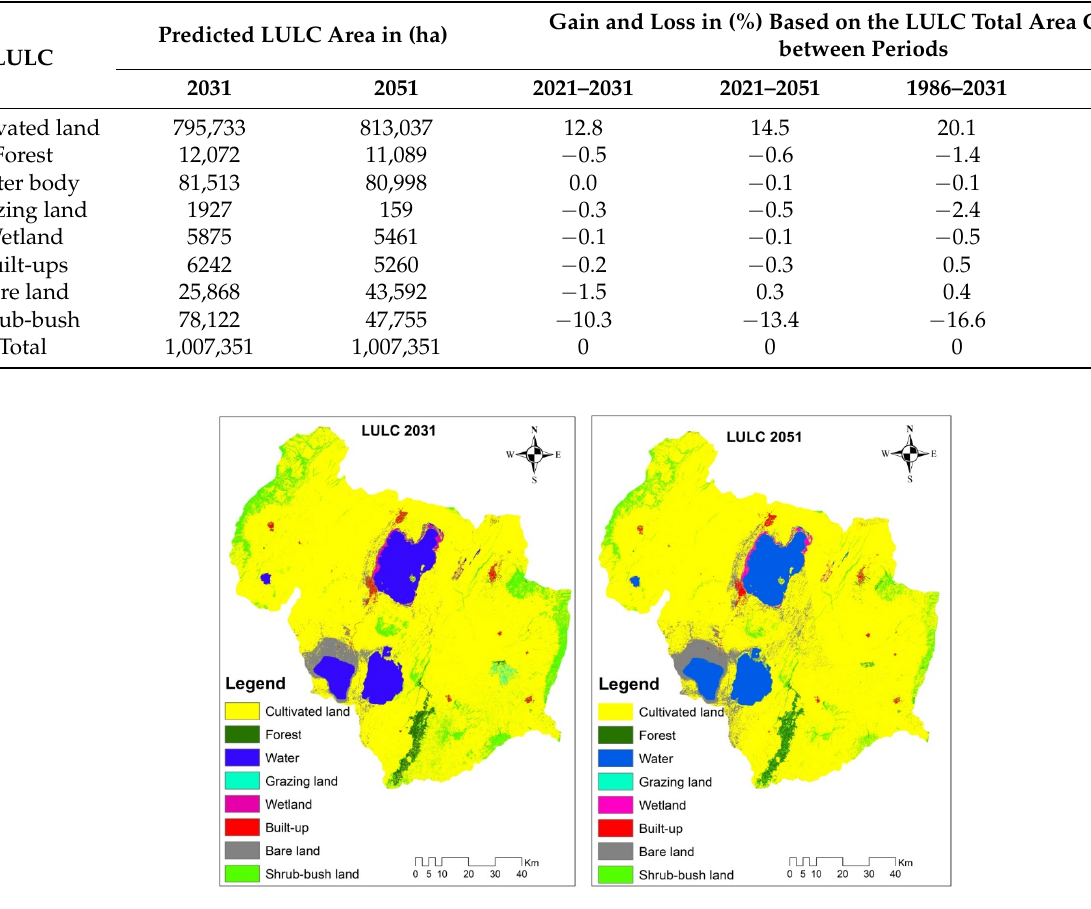
Figure 3. LULC maps of predicted 2031 and 2051.